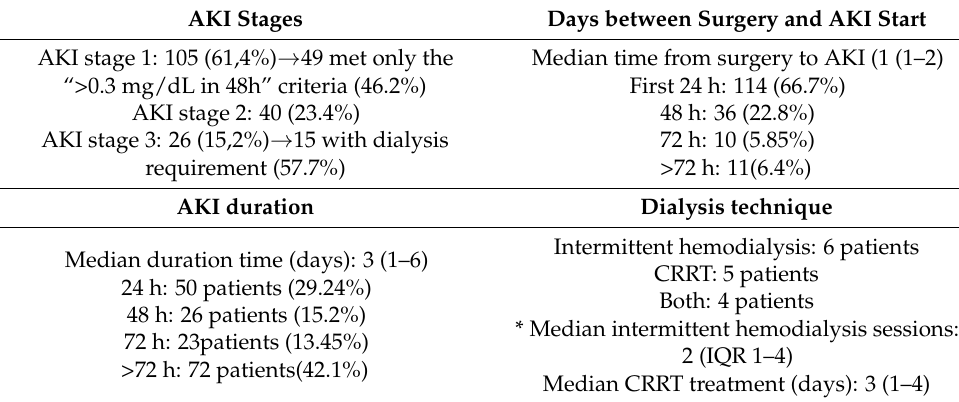
Table 3. Summary of acute kidney injury characteristics.